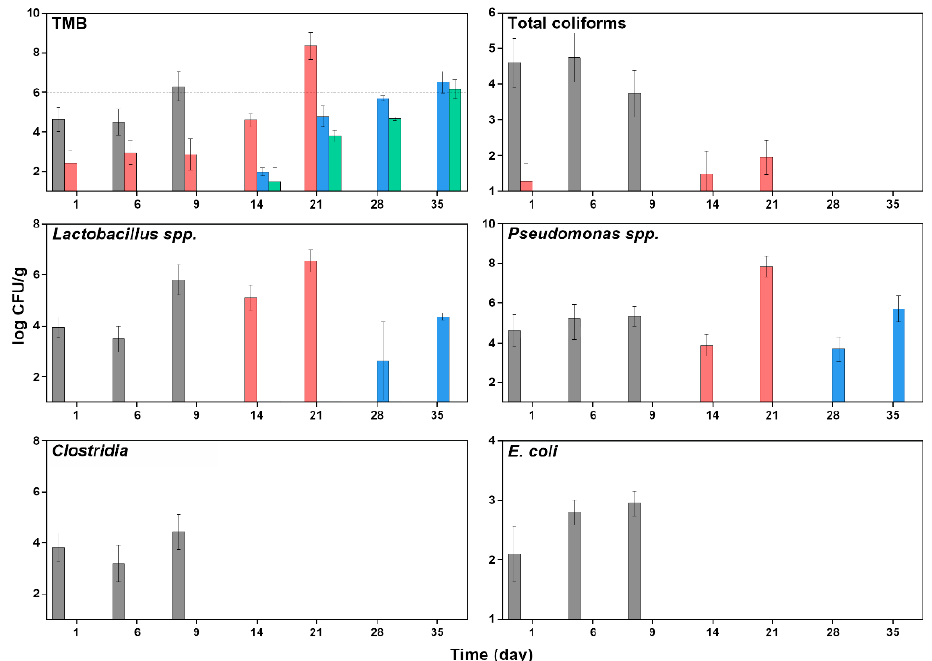
Figure 6. Changes in microbial cell loads (log CFU/g) of total mesophilic bacteria, total Coliforms, Lactobacillus spp., Pseudomonas spp., Clostridia , and E. coli during chilled storage of packaged striped prawn untreated (gray) or after treatment with HHP at 400 (red), 500 (blue), and 600 MPa (green).